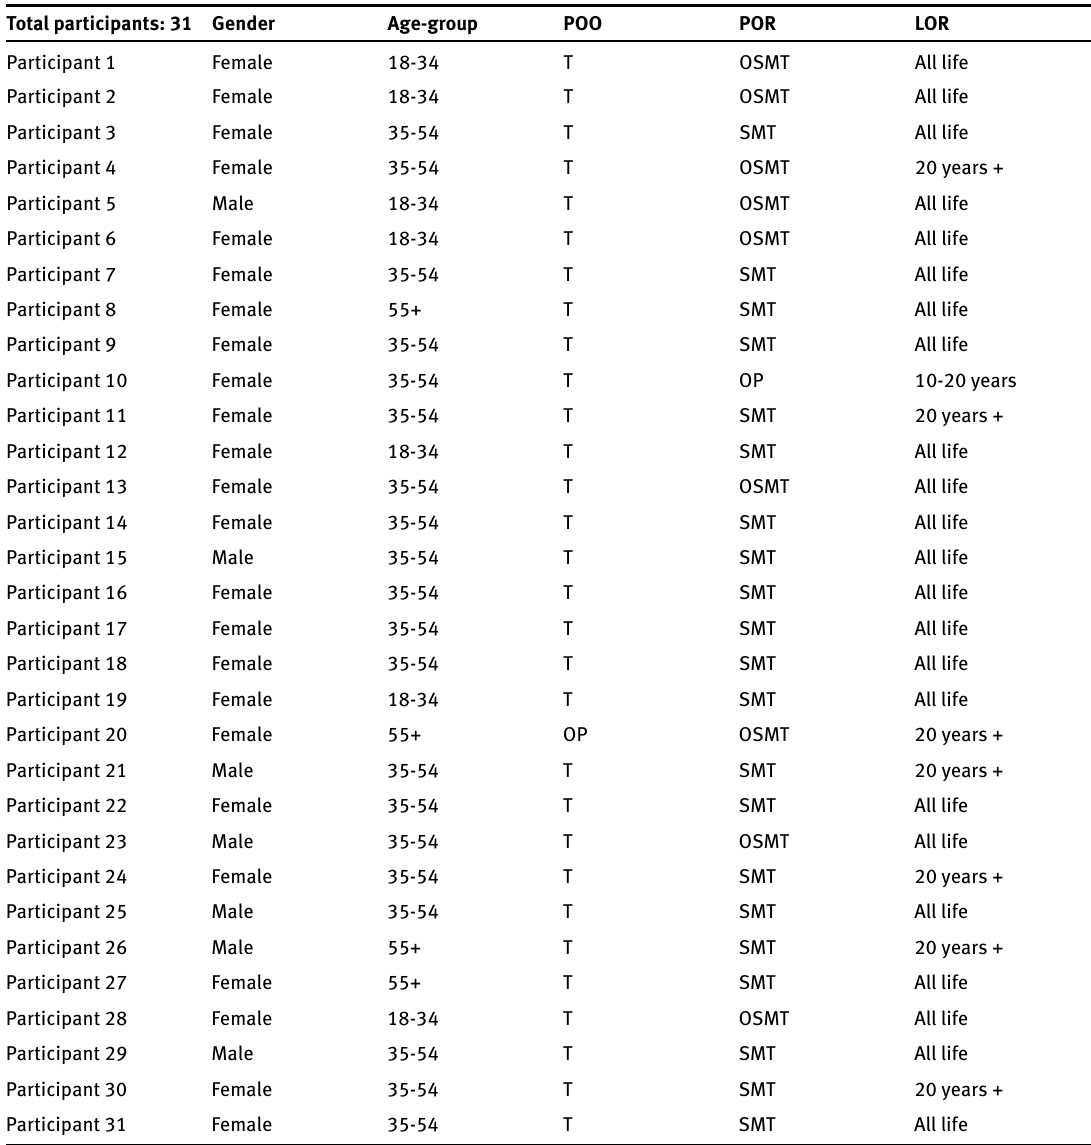
Table 1. Participants’ demographic